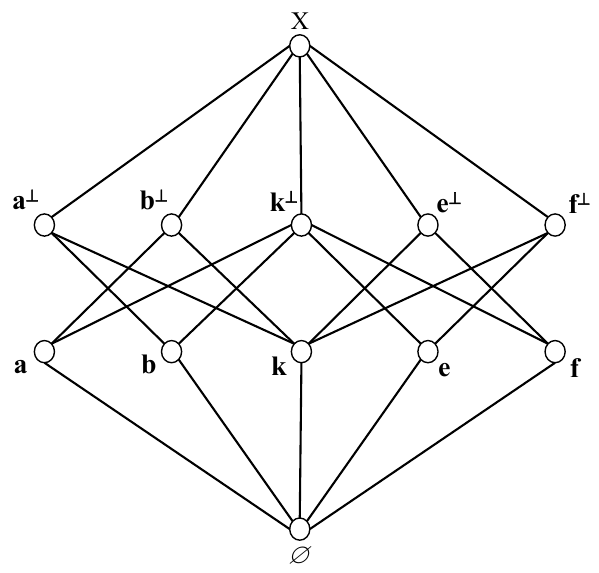
Figure 2. The lattice of propositions P = (cid:28) P , (cid:100) , (cid:101) , ⊥ , X , ∅ (cid:29) for experiment E (with ⊥ = − , k replacing c and d , X 1 = { a , b , k } , and X 2 = { k , e , f } , because of the theoretical assumption c iff d ). In this figure, the ⊆ relation is illustrated by moving along a line upward from an open circle (representing a proposition) to another open circle. X = { a , b , k , e , f } is the ⊆ -largest element of the lattice, ∅ the ⊆ -smallest element, and ⊥ is an ortho-complementation operation. Boldface letters represent propositions, e.g., a represents the proposition λ ( a ) = { a , e , f }